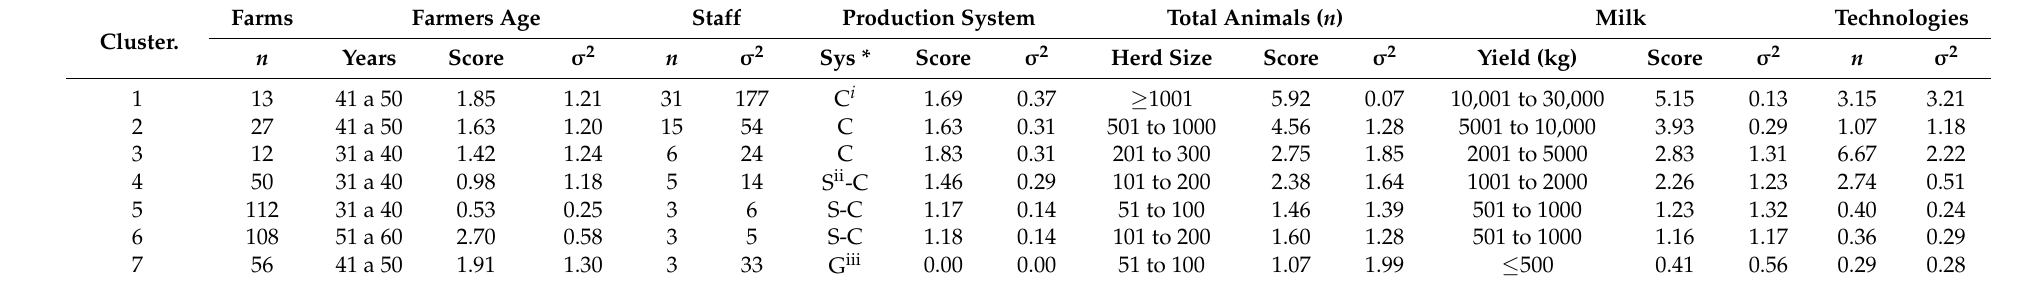
Table 1. Farms’ average traits based on variables used in the cluster analyses.